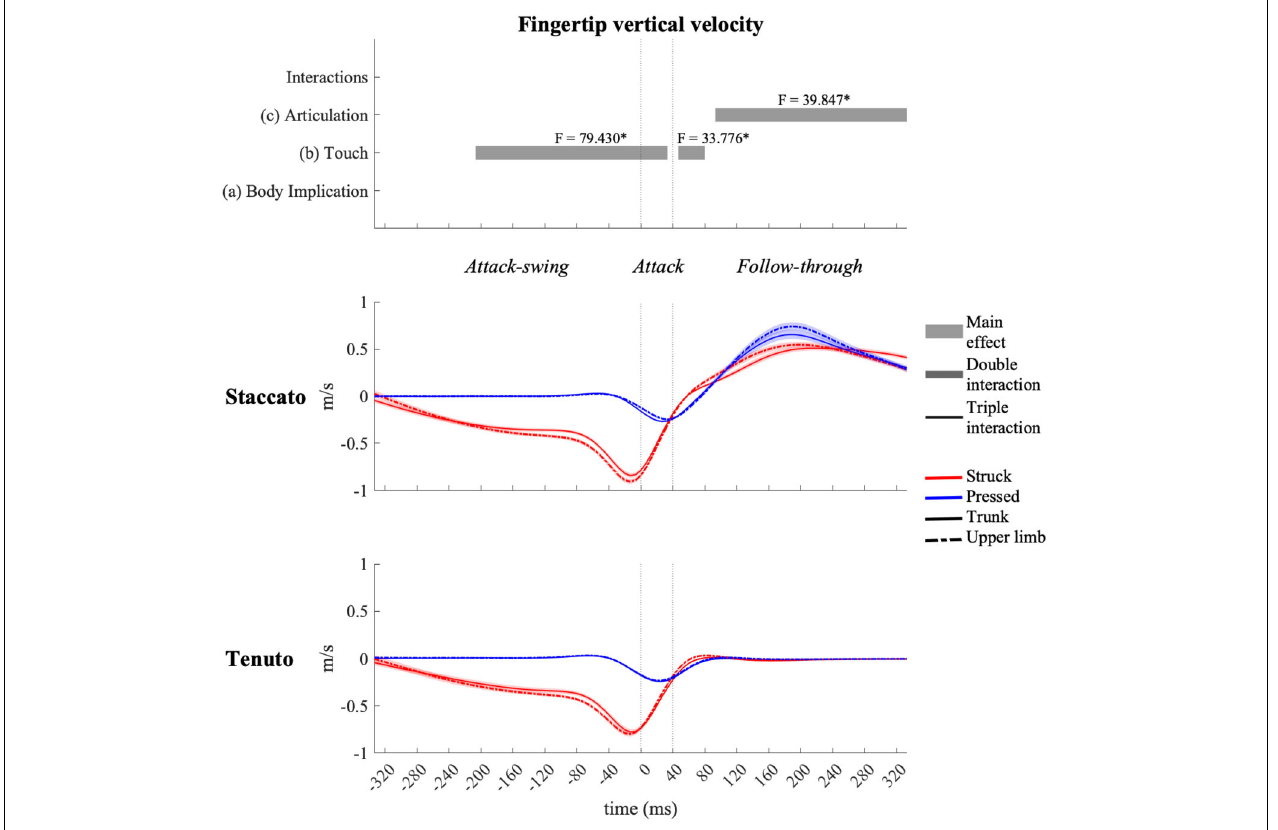
FIGURE 3 | Mean values (solid and dash-dotted lines) and 95% bootstrap confidence interval (shaded areas) of the fingertip vertical velocity during the three phases of the keystroke. Negative/positive values indicate downward/upward velocities. The top panel represents the results from the statistical parametric mapping of time-series values. * p -value ≤ 0.001. As explained in the methods (Section “Data Processing”), the fingertip shows an overextended downward velocity for approximately 30 ms after reaching the end of the finger–key descent due probably to both the finger’s forward rotation over the key and the absence of the distal and middle finger phalanges in our kinematic